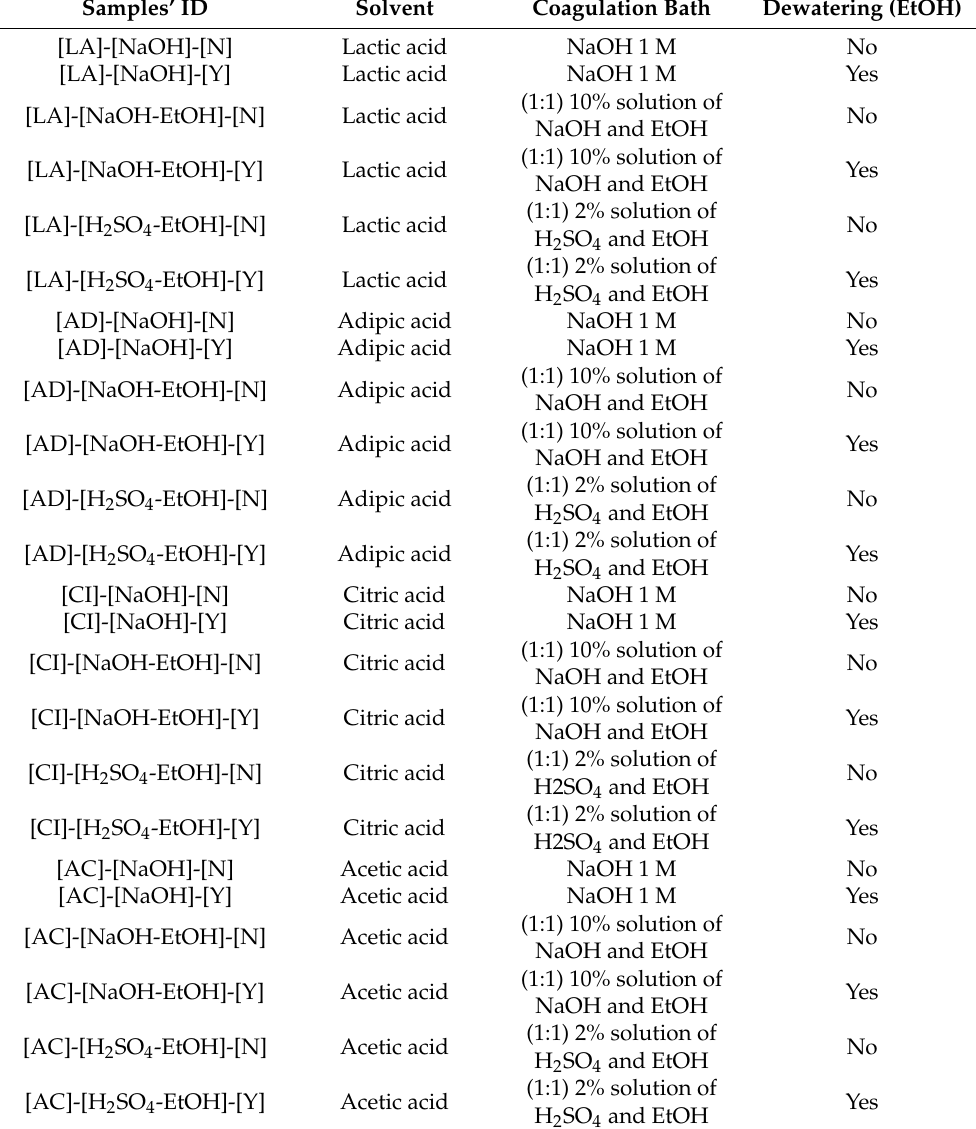
Table 2. The different conditions in which fibers were produced. Samples’ ID